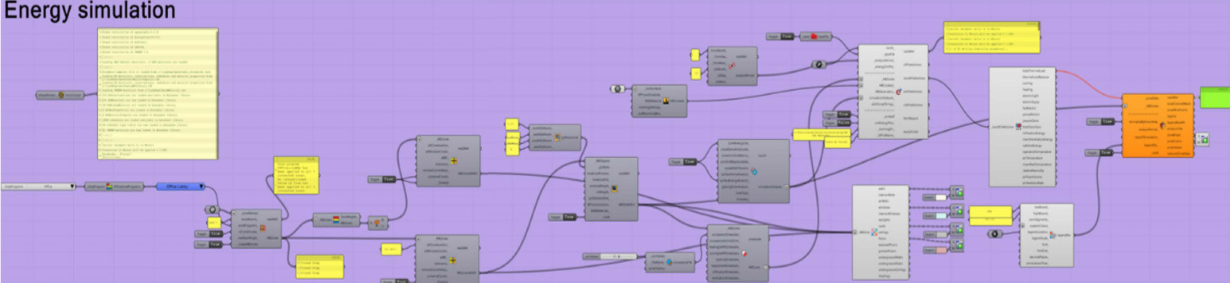
Figure 17. Grasshopper script of the energy simulation.